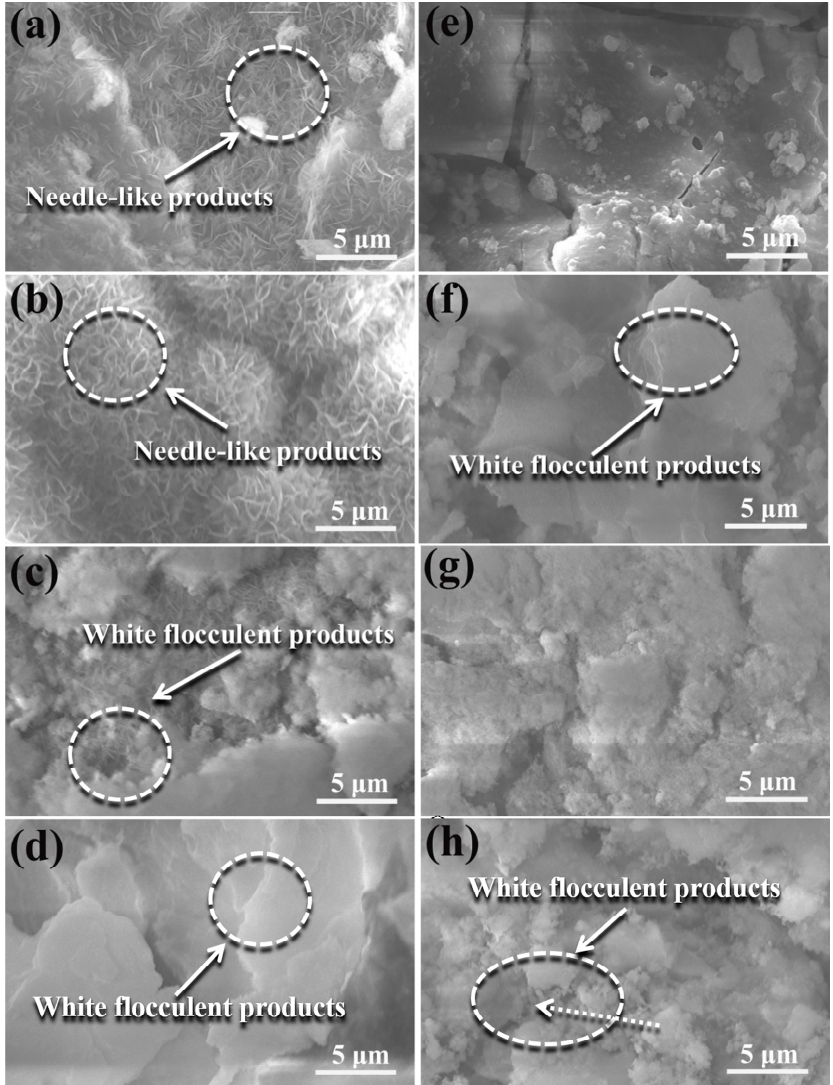
Figure 6. Morphologies of the uncoated and coated samples after immersion for 30 days: ( a ) 5 days, ( b ) 10 days, ( c ) 20 days, and ( d ) 30 days for uncoated sample, and ( e ) 5 days, ( f ) 10 days, ( g ) 20 days, and ( h ) 30 days for MAO coated sample,